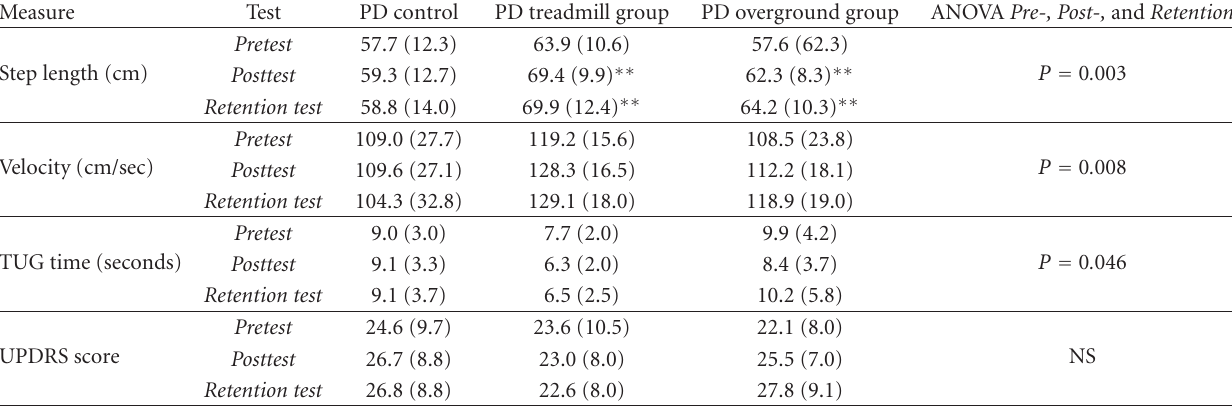
Table 2: Mean (6 standard deviation) of outcome measures from pre-, post-, and retention test.